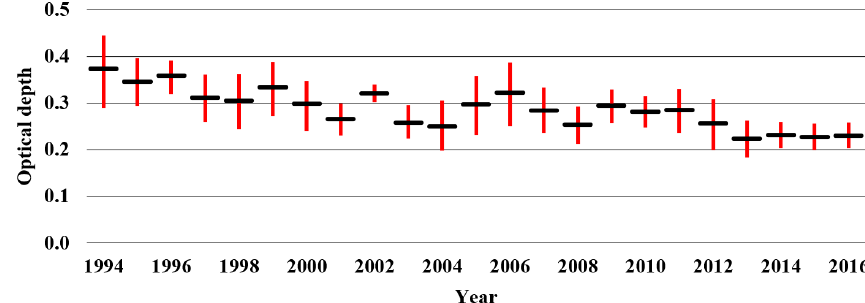
Figure 9. Annual averages of AOD and their uncertainty for the wavelength of 320nm, 1994–2016.